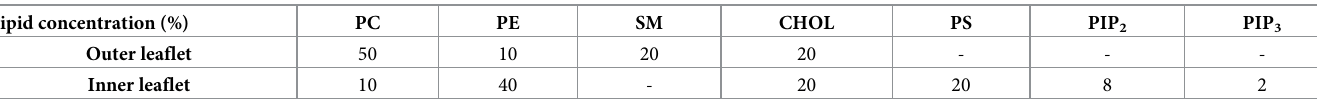
( γ ) penetrated the membrane more than Y166 of CD3 ε ( δ ). In addition, only one of the sub- units of the zz dimer mostly showed ITAM tyrosine contacts with lipid acyl chains. We also Table 1. Composition of lipid headgroups (%) in each leaflet of the membrane in all simulations. Lipid concentration (%) PC PE SM CHOL PS PIP 2 PIP 3 Outer leaflet 50 10 20 - - Inner leaflet 10